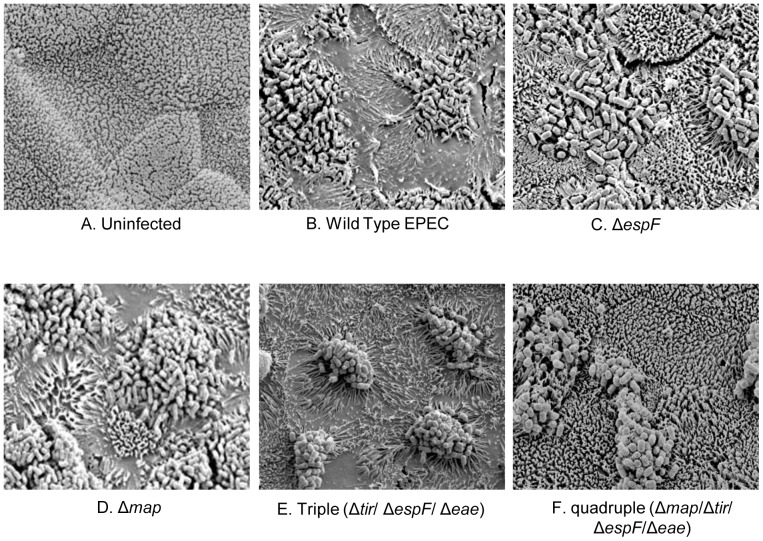
EPEC effacement on TC7 cells mimics in vivo-differentiated enterocytes.Scanning electron microscopy analysis of TC-7 cells reveals a highly homogeneous densely packed brush border (A) that is effaced by wild type EPEC (B) over a 120 minute infection period. No peripheral effacement activity was detected during infection with the ΔespF mutant (C) whereas the Δmap mutant behaved like the wild type strain (D). A triple mutant (ΔespFΔtirΔeae [latter encodes Intimin])hyper-effaced microvilli (E) with removal of Δmap from this strain abolishing effacement activity (F).